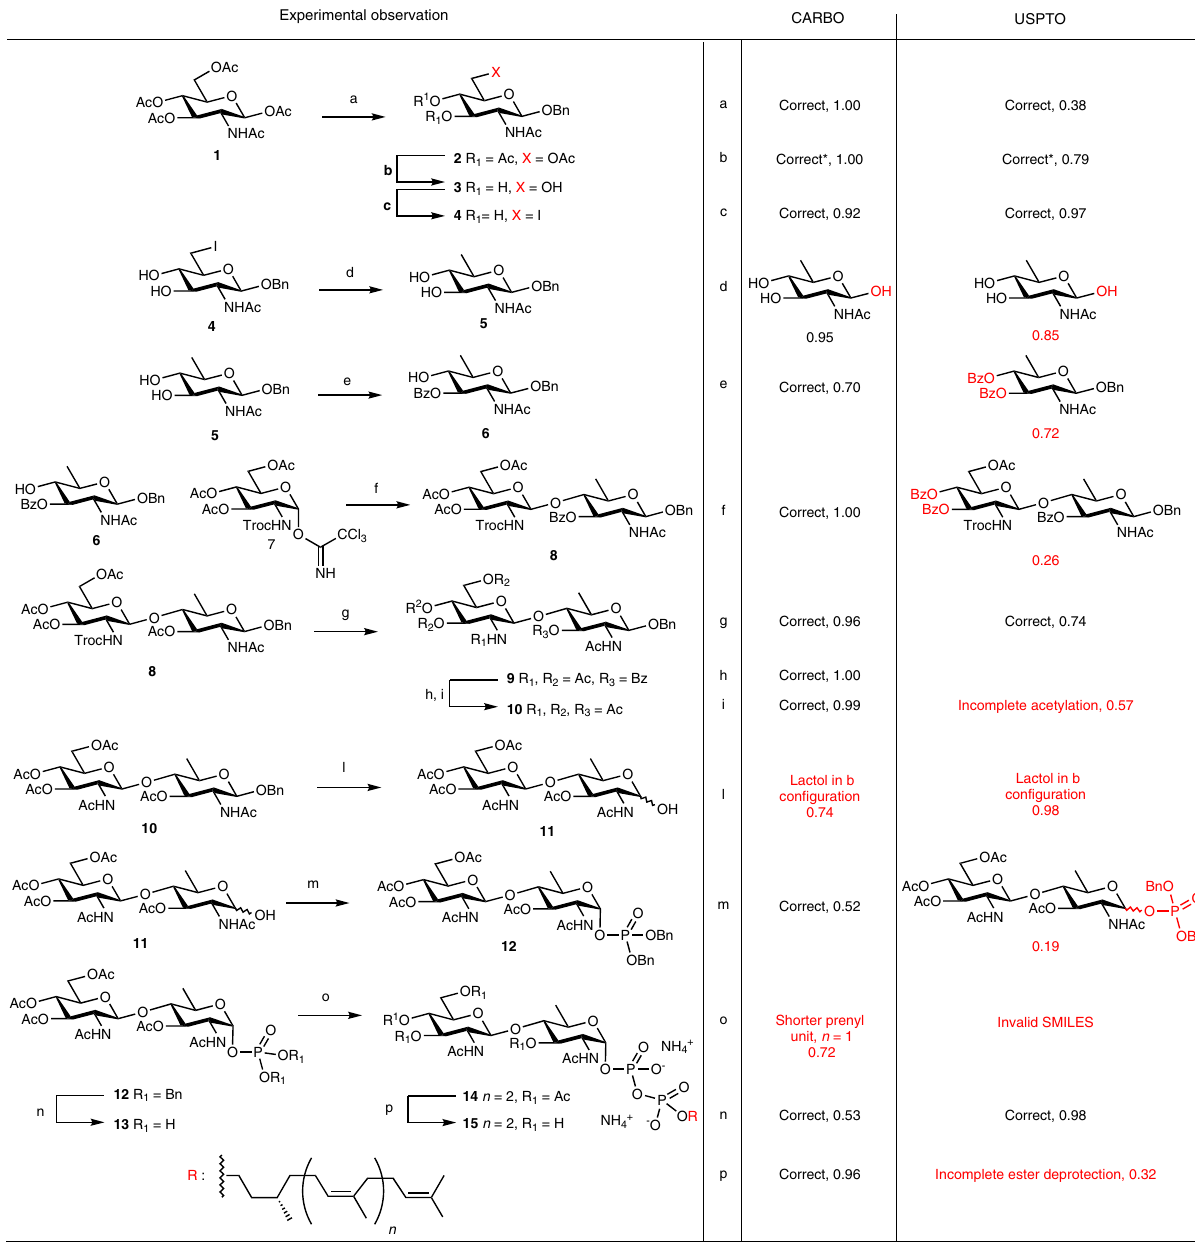
Rhamnopyranoside 16 (step no. 10), the dif fi cult regio- and stereoselective glycosylation at position 3 of the terminal fucosyl in disaccharide 18 (step no. 24) as well as the regioselective protection of the same disaccharide at position 3 (step no. 29), all of which are nonobvious even for synthetic chemists (Fig. 5).